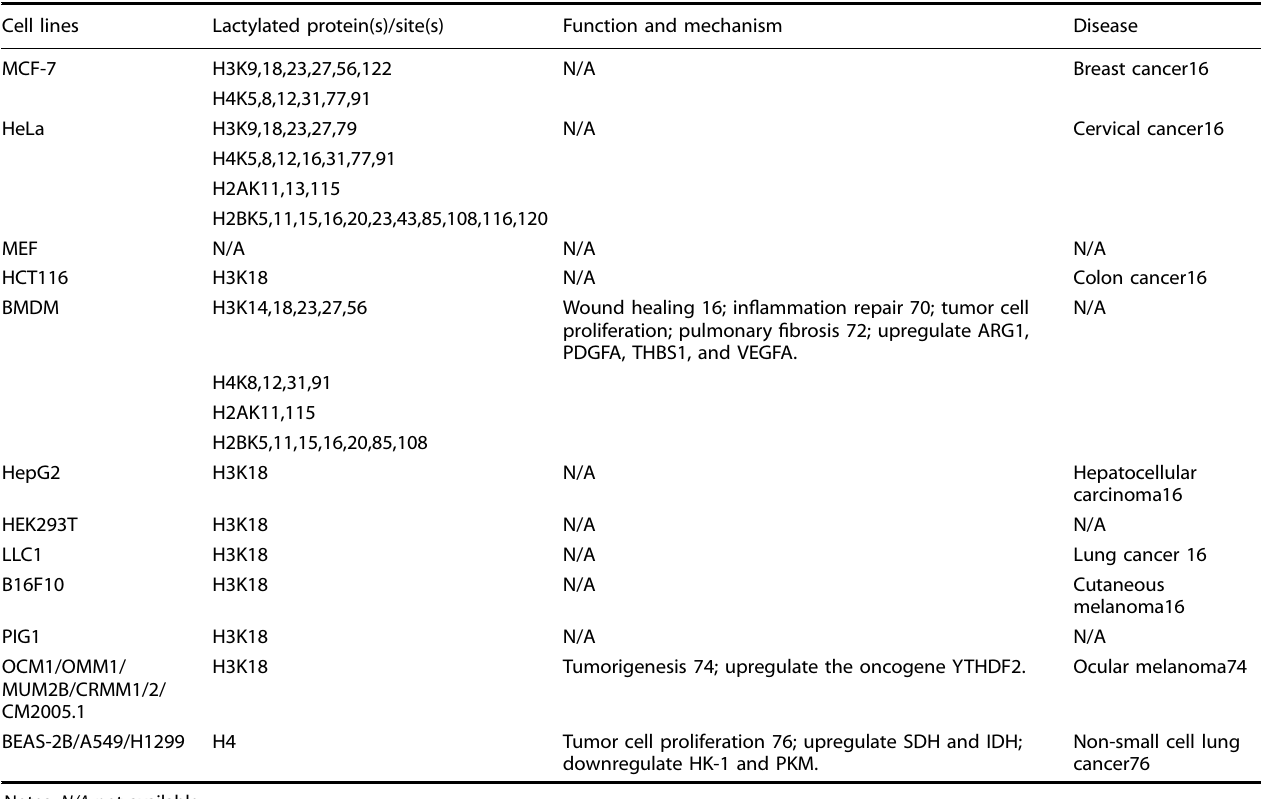
Table 1. The regulation of lactylation in cell lines and diseases Cell